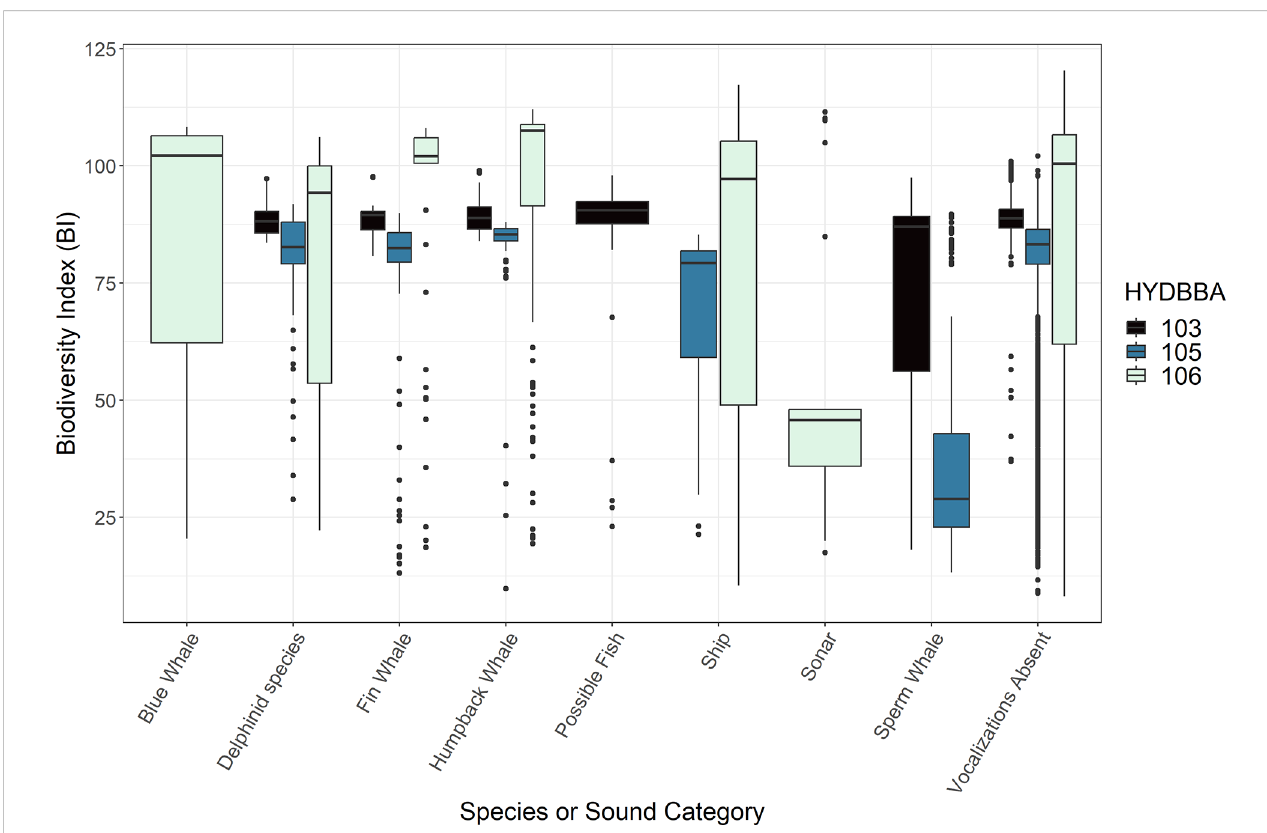
FIGURE 3 Box plots representing measurements of Bioacoustic Index (BI) associated with underwater sounds. Data are organized by recorders located on the shelf (106), the slope (105) and at the base of the slope (103). Marine mammal species and human-made sounds vary for each recorder resulting in some sound types with only one or two box plots. All recorders include a plot for data that contained no annotated sound (labeled ” Vocalizations Absent “